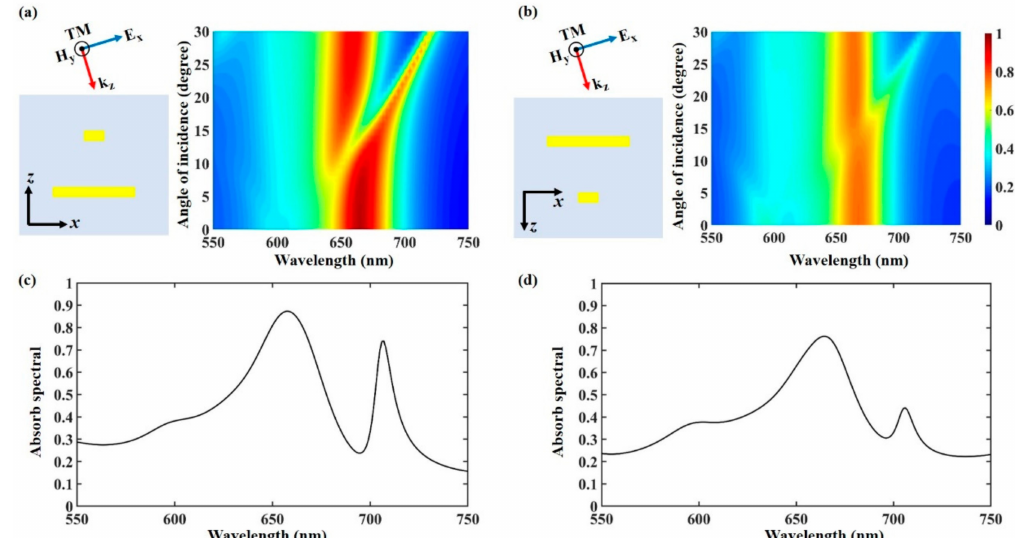
Figure 6. Absorption spectra of the proposed bilayer metasurface under forward ( a ) and backward ( b ) TM-polarized light incidence with di ff erent incident angles. The absorption spectral under forward ( c ) and backward ( d ) oblique TM-polarized light at the incident angle of 25 ◦